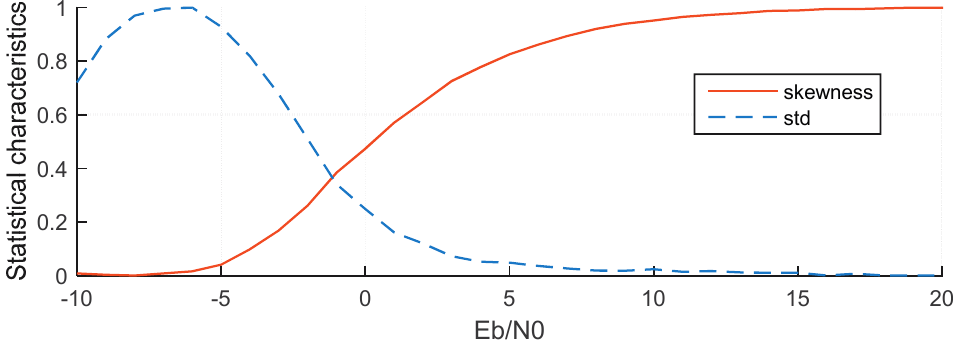
Figure 9. Two normalized statistical parameters change with E b / N 0